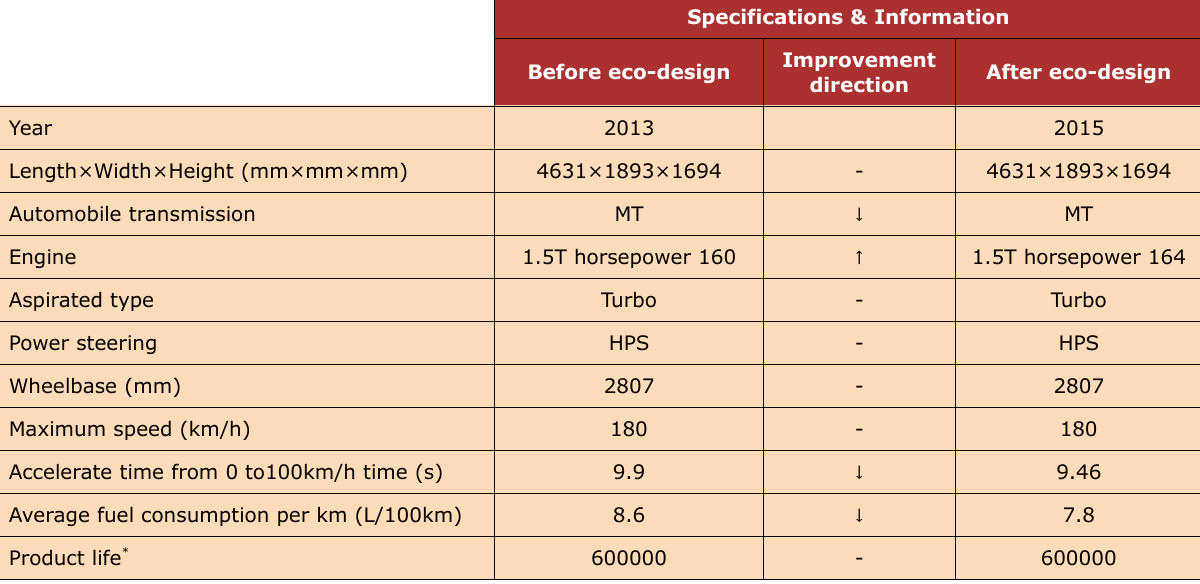
Table 1. Product specifications and information in 2013 and